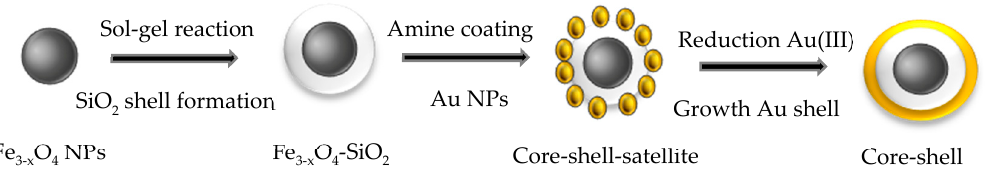
Figure 3. Schematic view of the formation of a silica layer around an iron oxide core before the deposition of gold satellites and shell by seed-mediated growth.